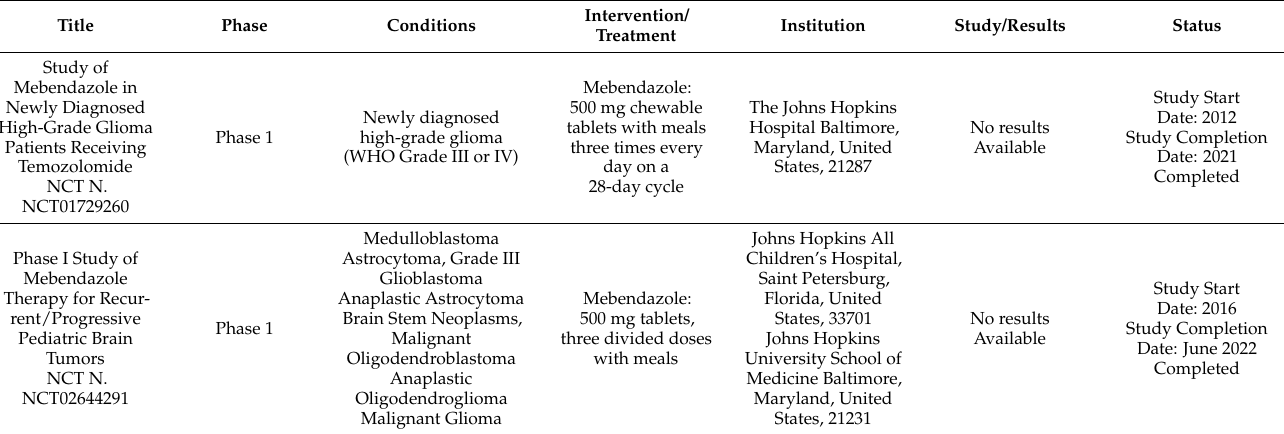
Table 4. Clinical trials of MBZ in cancer